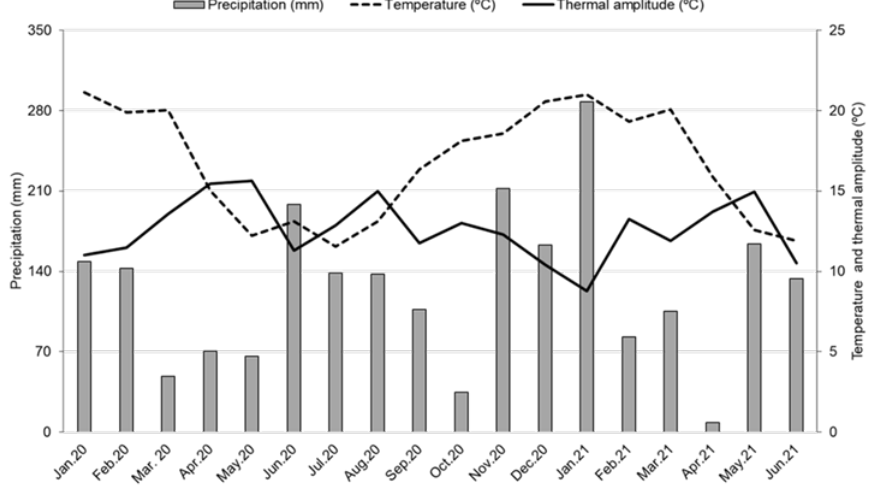
Figure 1. Monthly precipitation (mm), air temperature ( ◦ C), and thermal amplitude ( ◦ C) from the field experiment, Curitibanos, Santa Catarina, Brazil (January 2020 to June 2021). Data were obtained online: https://ciram.epagri.sc.gov.br (accessed on 23 August 2021).